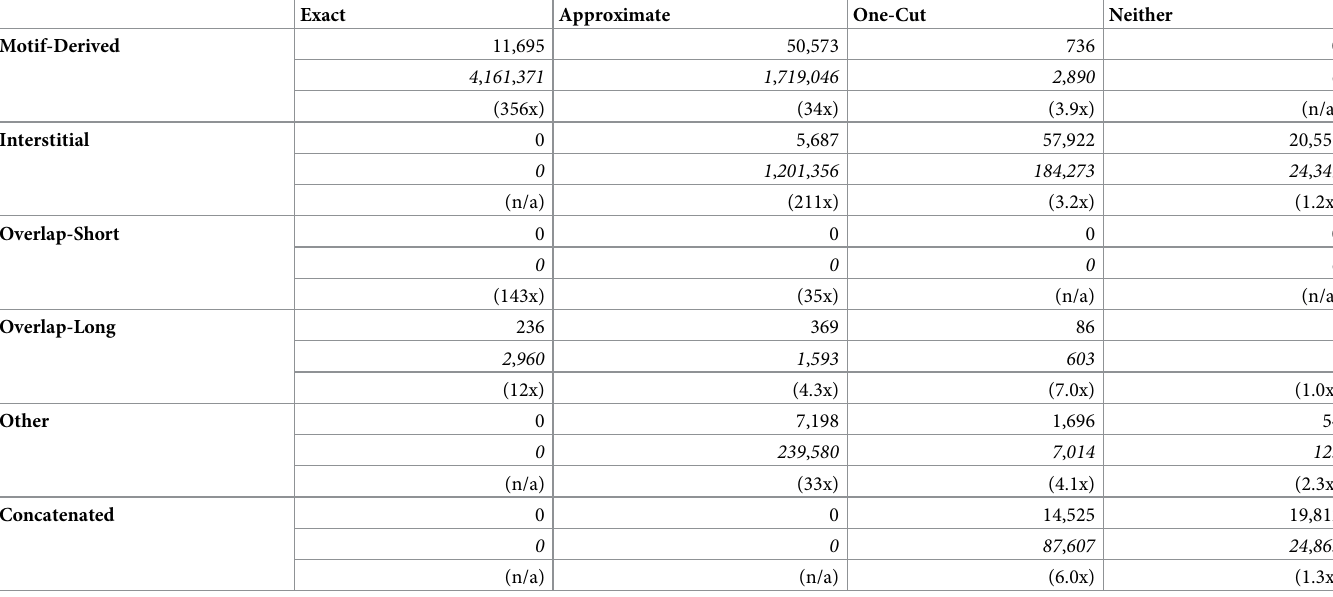
Table 5. Comparison of real sequence reads with theoretical digest fragments of E . coli DHB4 a .